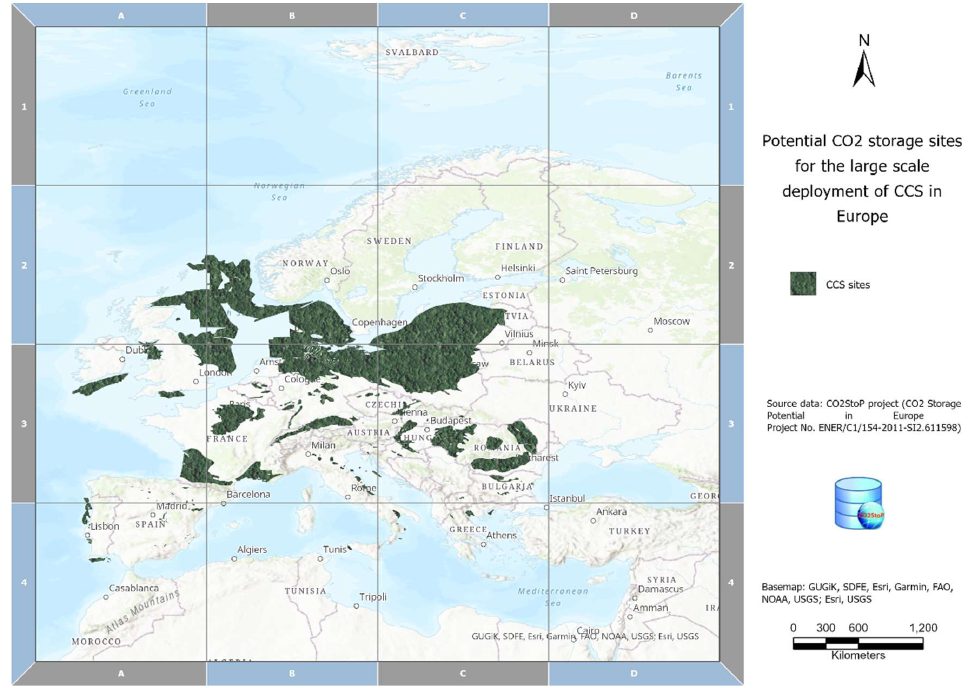
Figure 3. Representation of potential European CCS storage sites. Green color depicts the CCS sites. Data were retrieved and modified from CO 2 StoP project (CO 2 Storage Potential in Europe. Project No. ENER/C1/154-2011-SI2.611598). Un-mineable coal seams have been proposed as suitable for CO 2 storage purposes. Lately, the possibility of storing CO 2 in basalt formations is being considered. Aquifers and oil reservoirs involve storing CO 2 within the pore volumes of subsurface rocks. The injected CO 2 is restrained on the coal matrix as a result of adsorption into the coal seams. Carbon mineralization (i.e., a chemical reaction) is the storage mechanism in basalt. Ge- ological storage is not possible to accomplish globally as Earth’s geology differs. Sum- marizing, four options appear to predominate for storing CO 2 in geological formations, including saline aquifers, depleted oil reservoirs, coal seams, and silica-undersaturated basaltic rock formations. Nowadays, around the Europe Union, there are Commercial- and Pilot/Demonstration-scale CCS Facilities. These CCS Facilities, both active and those in the implantation stage, are assembled in Table 1, Figure 4. Table 1. Commercial- and Pilot/Demonstration-scale CCS Facilities around Europe. Adapted from: https://co2re.co/FacilityData. Project